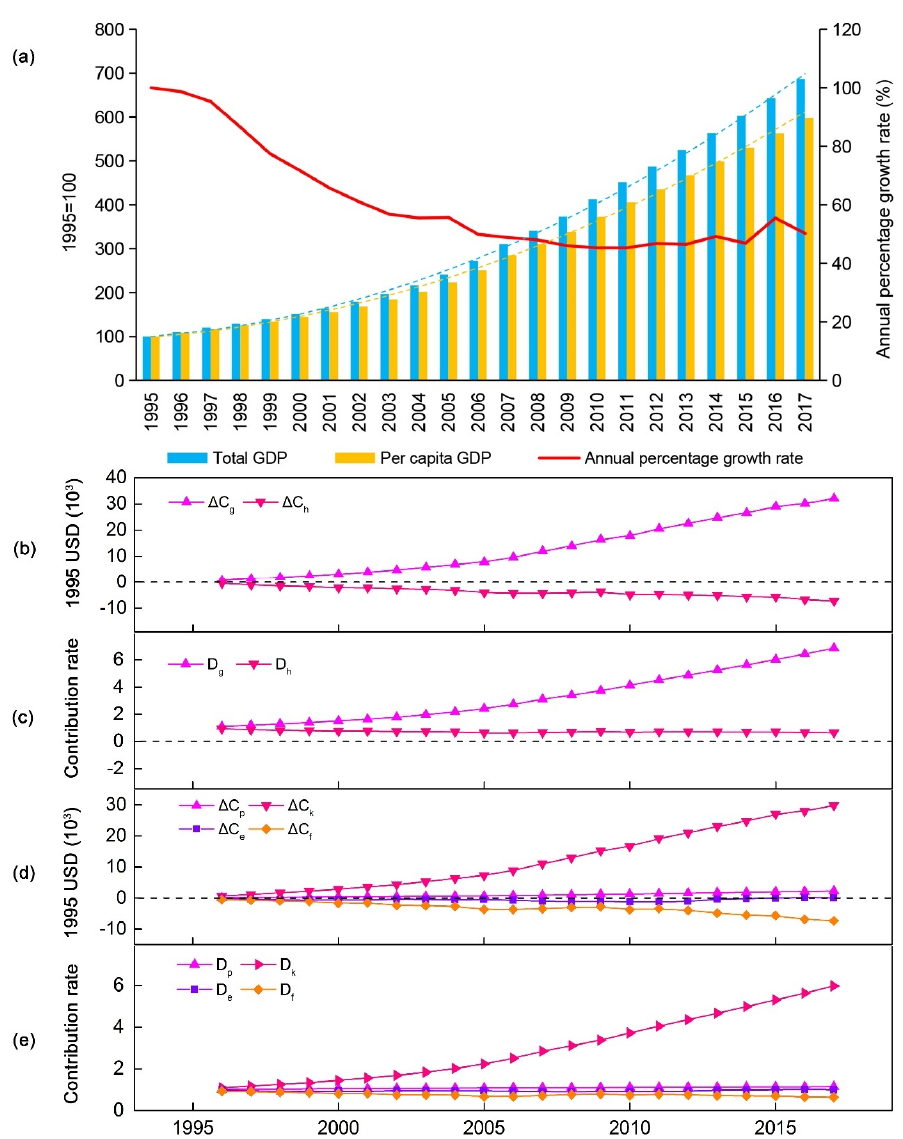
Figure 6. The contribution of different demographic and economy effects to the total GPI. ( a ) Indi- cators of real GDP, real per capita GDP, and population growth rate in China from 1995 to 2017. ( b ) and ( c ) represent the contribution value and contribution rate of g and h to total GPI, respectively. ( d ) and ( e ) represent the contribution values and contribution rates of p , k , e, and f to total GPI, respectively.